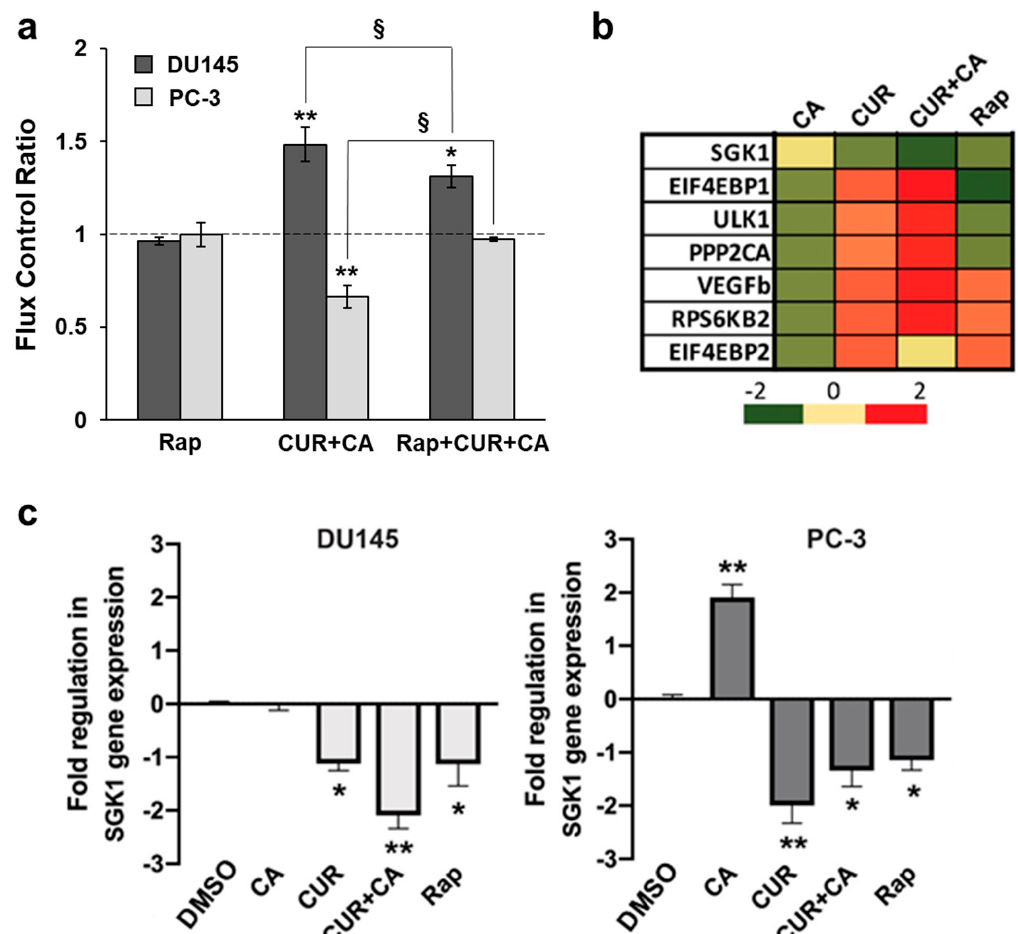
Figure 9. Effects of polyphenols and rapamycin on mitochondrial respiration and expression of mTOR downstream genes. ( a ) Rapamycin inhibits the effects of the polyphenol combination on mitochondrial respiration. Cells were pretreated with vehicle (DMSO) or 5 µ M rapamycin (Rap) for 1 h followed by the addition of vehicle or 7 µ M CUR and 5 µ M CA (CUR + CA). Data are presented as mean ± SEM ( n = 3) relative to DMSO. Statistically significant differences for the indicated groups vs. DMSO (* p < 0.05 and ** p < 0.01). § p < 0.05, significant differences between the indicated groups (Student’s t -test). ( b ) Changes in mTOR downstream transcriptional profile upon treatment of DU145 cells with 5 µ M rapamycin or 7 µ M CUR, 5 µ M CA or CUR + CA) for 24 h, relative to DMSO. ( c ) Quantitative analysis of SGK1 gene expression. Data are presented as fold regulation vs. DMSO (mean ± SEM; n = 3), where DMSO is set as 0. Statistically significant differences for treatments vs. control (DMSO): * p < 0.05 and ** p < 0.01.